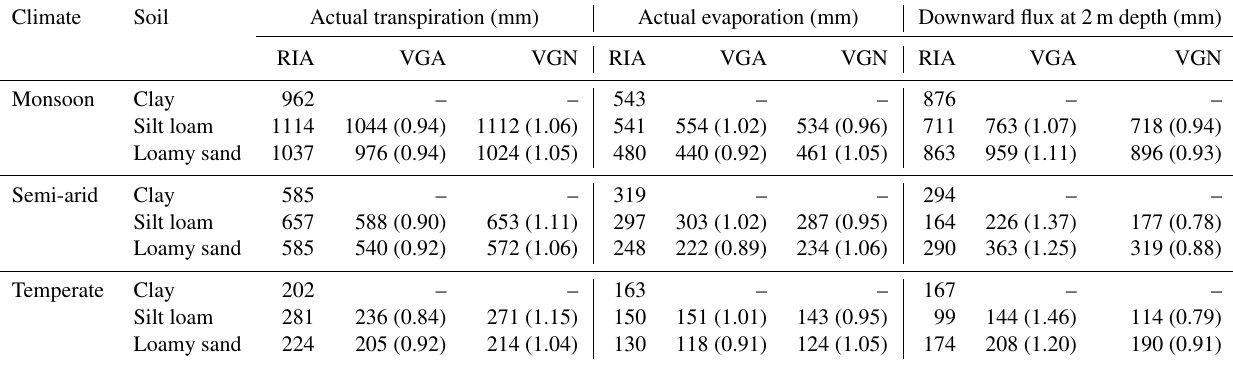
Table 4. Average of the annual sums of the actual transpiration and evaporation and of the outflow across the lower boundary of the simulated soil profiles. The averages were calculated for the final 6 years of the simulation periods. The values in parentheses are scaled with respect to the corresponding value for